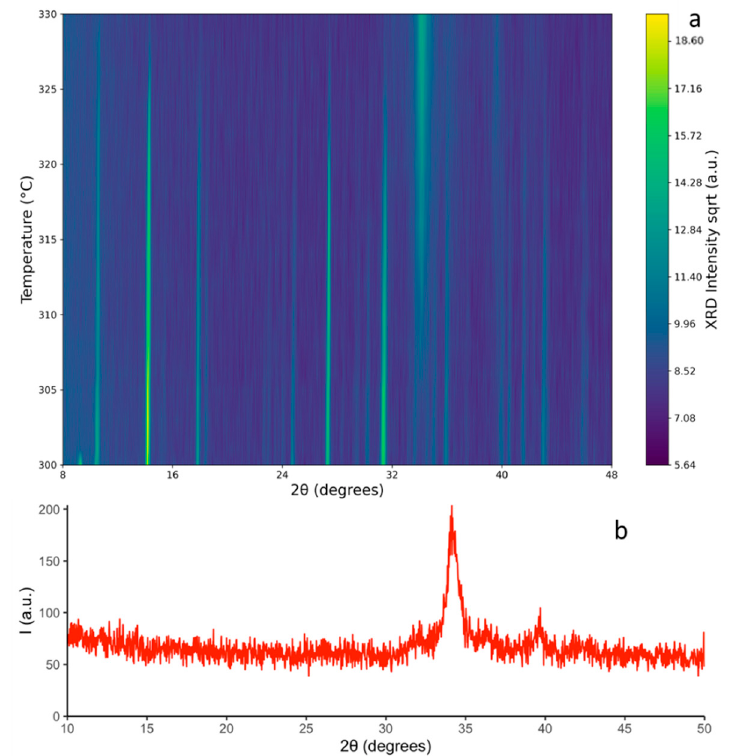
Figure 7. ( a ) X-ray powder diffraction thermal evolution of commercial cobalt (II) acetate heated under N 2 atmosphere from 300 to 332 °C in 2 °C steps. The experiment was stopped as soon as only Zn-blende-type structure for CoO was observed; ( b ) XRD pattern of the final product obtained at 332 °C, showing the two characteristics peaks of Zn-blende-type CoO (PDF-00-042-1300).